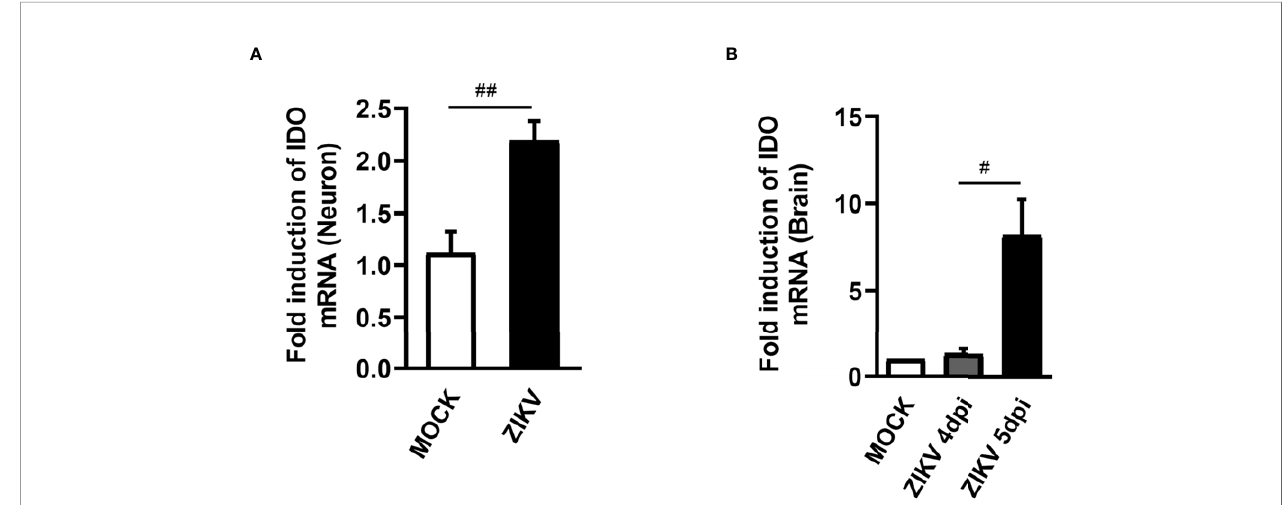
FIGURE 1 | IDO-1 expression induced by ZIKV infection. (A) Primary culture of cortical-striatal neurons from C57BL/6 mice on D5 were infected with ZIKV (MOI 0.1) and after 48 hours the cells were harvested. (B) Type I interferon receptor de fi cient mice (A129) were inoculated (i.v) with 4x10 3 PFU/200 m L of ZIKV. At day 4 and 5 of infection, the brain was harvested. RNA extraction and subsequent Real time PCR analysis of IDO-1 expression in the brain and neuronal primary culture was done. Results are expressed as mean ± SEM and are representative of two independent experiments. Statistically signi fi cant differences were assessed by Mann Whitney test. (#) for P ˂ 0.05 and (##) for P ˂